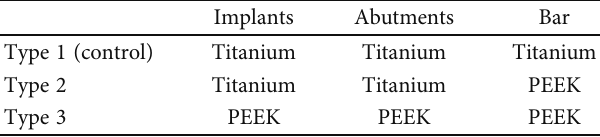
Figure 2: Final model (mandible with a fi xed prosthesis) and load and constraint conditions. Table 1: Three assemblies of materials for “ All on four ”